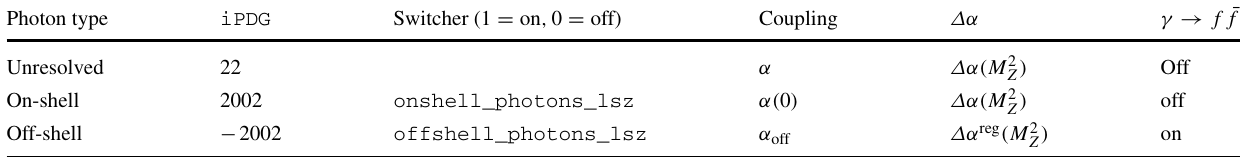
the standard user-defined coupling α is used, and the related δ Z ( on / off ) factors are deactivated. As indicated in the last column, contributions from collinear γ → f ¯ f splittings are included in Catani–Seymour’s = 1) I -operator (see Sect. 3.4) only for off-shell